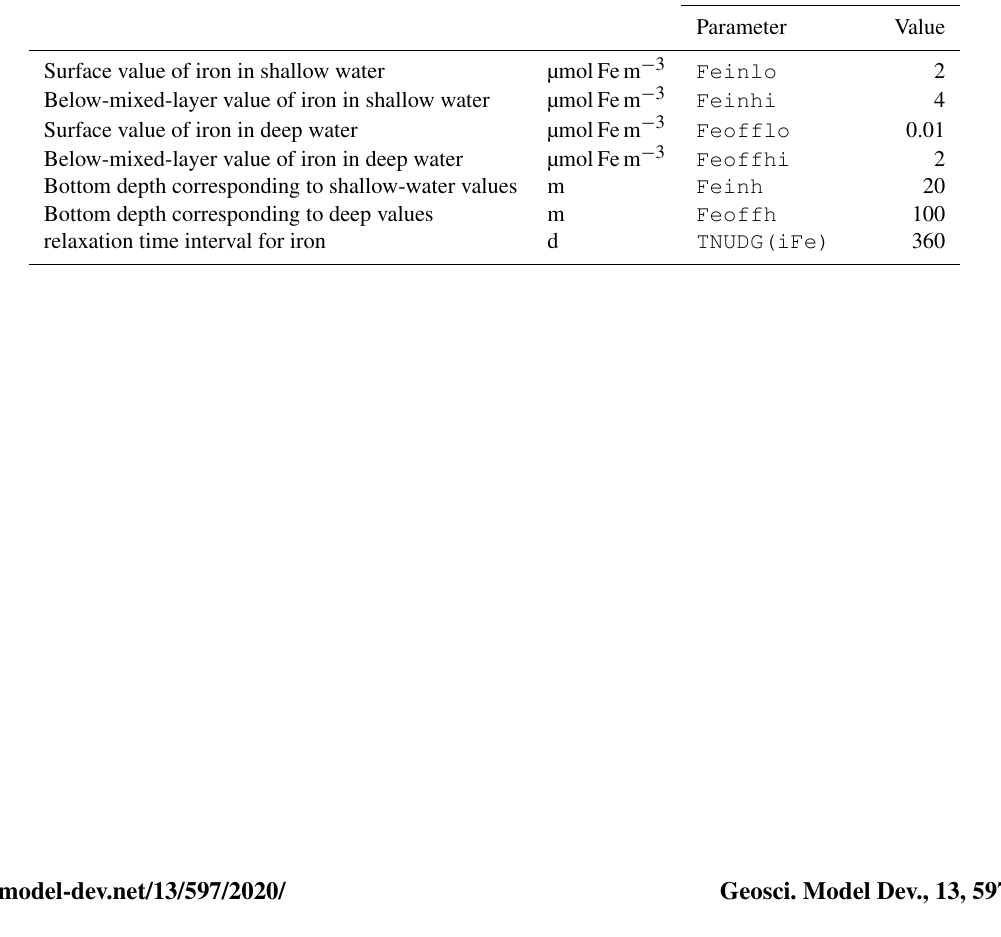
Table A13. Notation and description for input parameters related to state variable nudging. Description Units